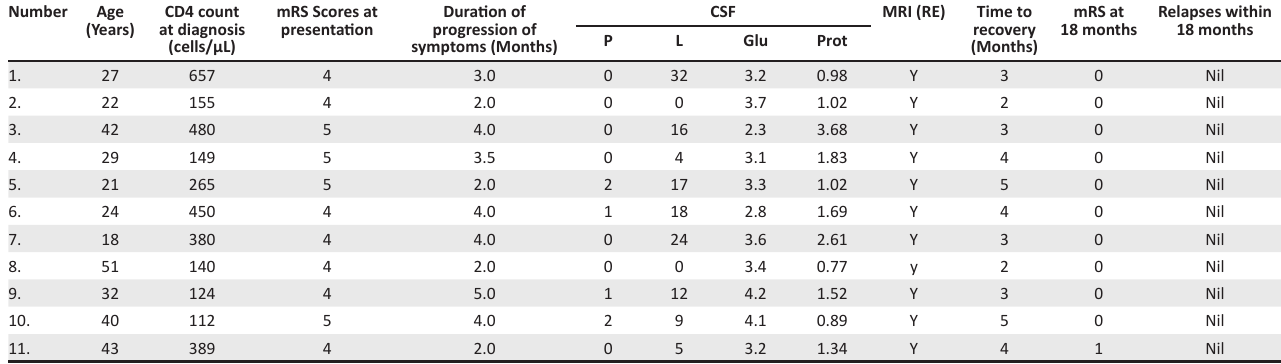
TABLE 1: Demographic, laboratory, and radiological features of motor lumbosacral radiculopathy. Number Age CD4 count (Years) at diagnosis